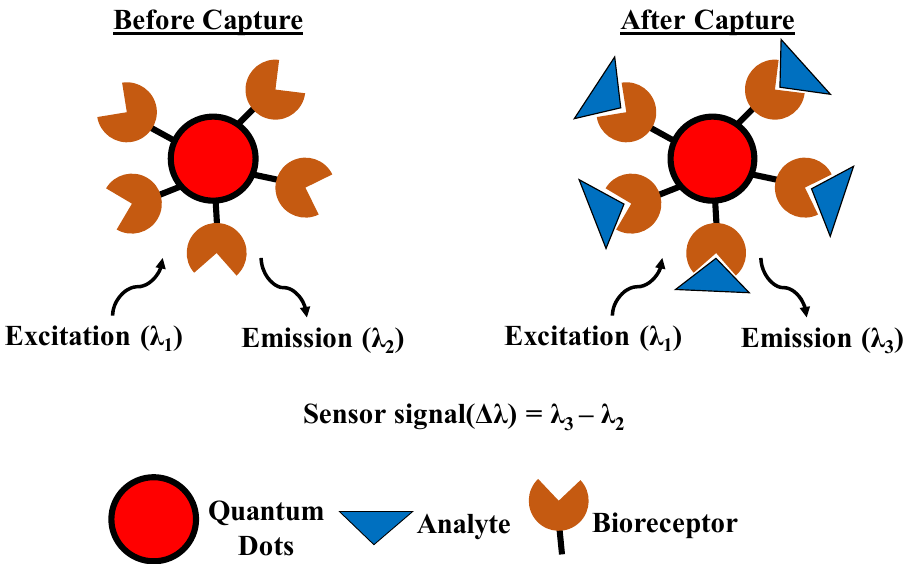
Figure 7. Schematic representation of fluorescence resonance energy transfer in quantum-dot-based biosensors. Successful capture of analyte results in change in the wavelength of emitted light. This change is a measure of captured analyte.